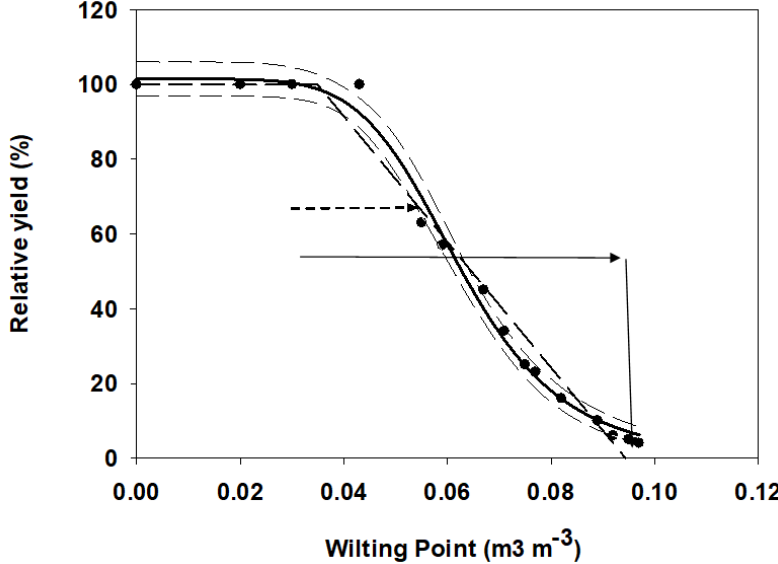
Figure 3. Relative yield as a function of increased wilting point affected due to increased salinity. The horizontal dashed arrow points at MH model and the solid lines pointing at the value of WP when relative yield = 50%.